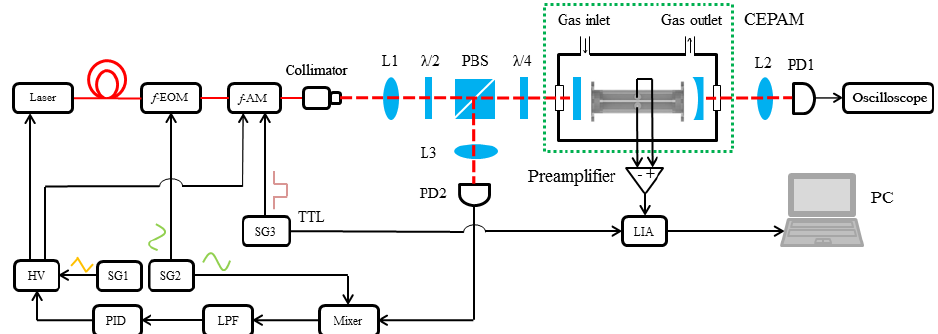
Figure 4. Experimental setup of the CEPA sensor system: f -EOM, fiber-coupled electro-optic modulator; f -AM, fiber-coupled amplitude modulator; L1, mode-matching lens; λ/ 2, half-wave plate; PBS, polarization beam splitter; λ/ 4, quarter-wave plate; L2 and L3, focusing lenses; PD, photodiode detector; SG, function signal generator; LPF, low-pass filter; PID, proportional–integral–derivative controller; HV, high-voltage amplifier; LIA, lock-in amplifier; PC, personal computer.